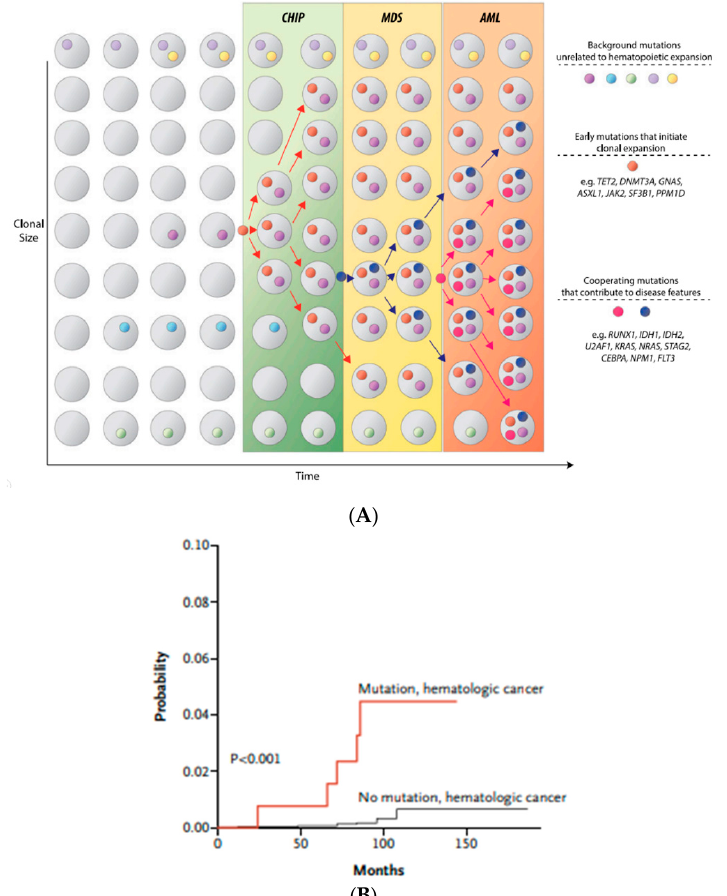
Figure 3. ( A ) CHIP as a precursor to hematologic neoplasms. Sequential acquisition of somatic mutations leading to clonal instability and survival advantage of mutated cells leading to expansion of neoplastic clones. Adapted from Steensma et al. [85]; ( B ) Cumulative incidence of hemato- logic malignancies. With increasing number of somatic mutations acquired during aging (CHIP), there is a proportional increase in the risk of developing hematologic malignancies. Adapted from Jaiswal et al.